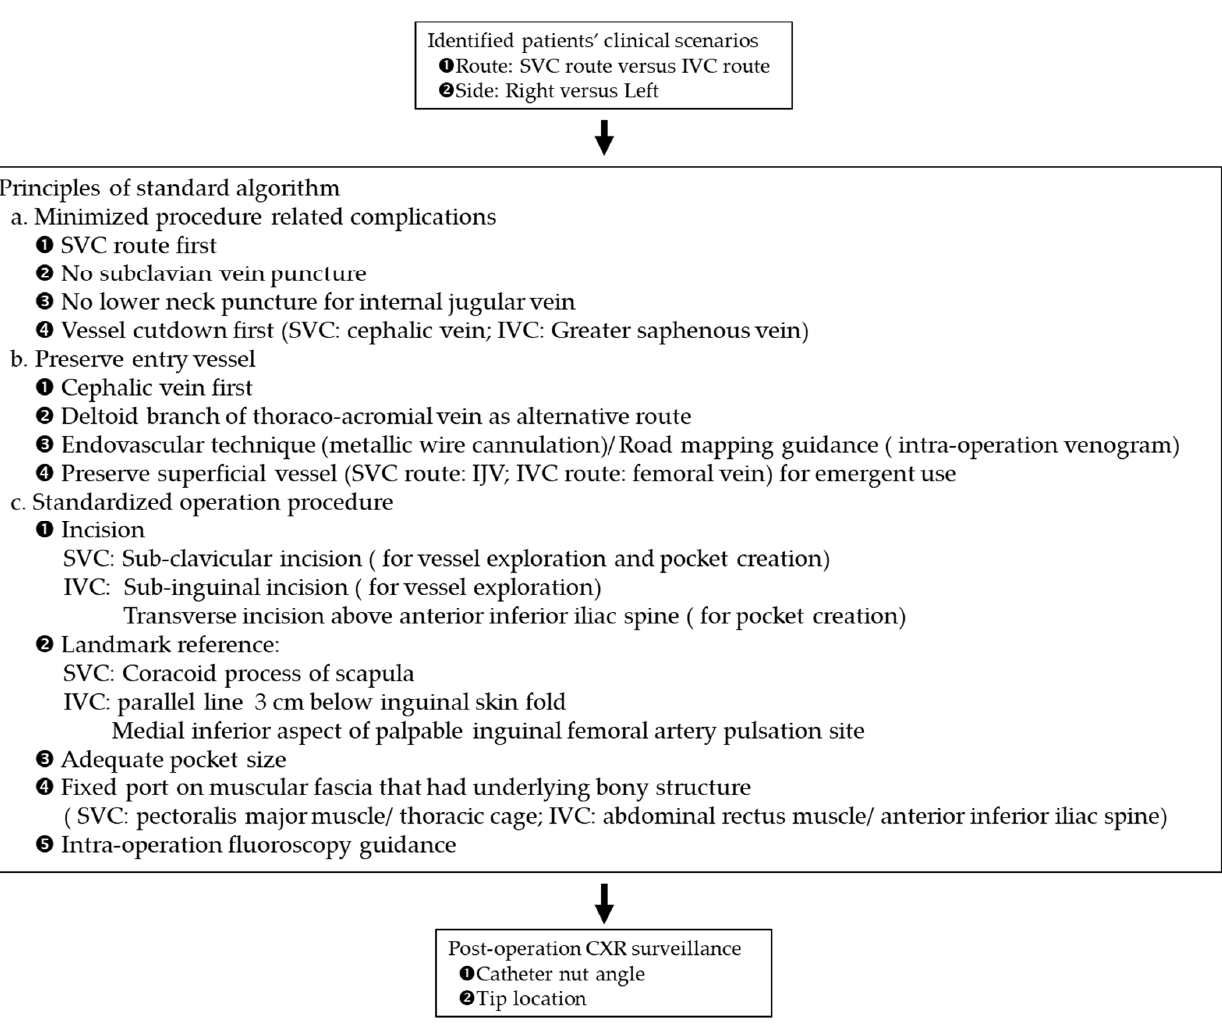
Figure 1. Standard algorithm of intravenous port implantation.